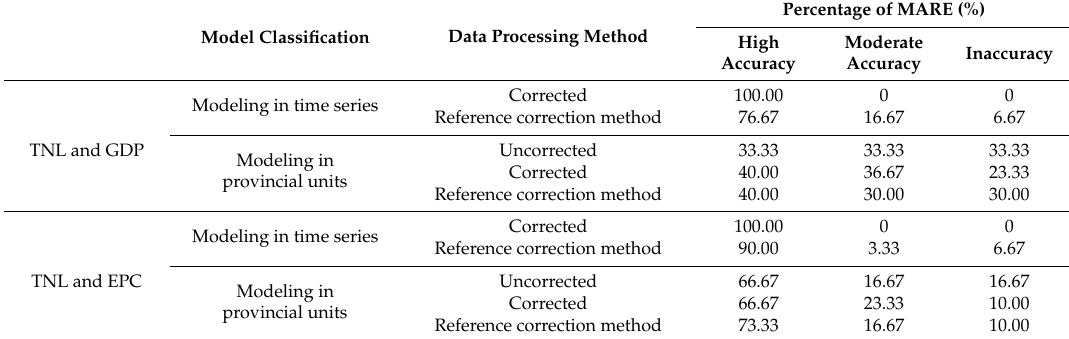
Table 14. Di ff erent classes of predicted accuracies for GDP and EPC under three data process